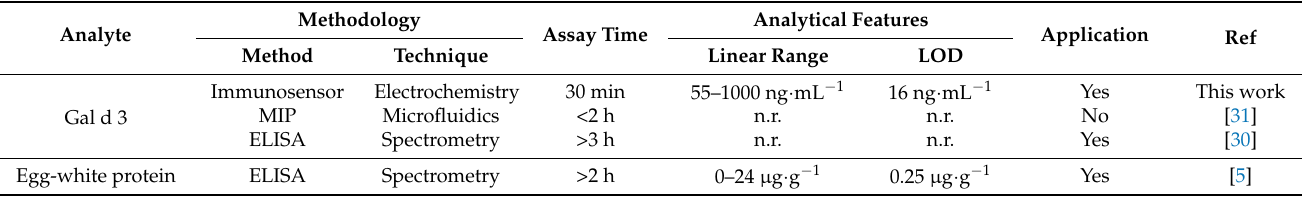
Table 2. Summary of analytical methods for egg-white allergen